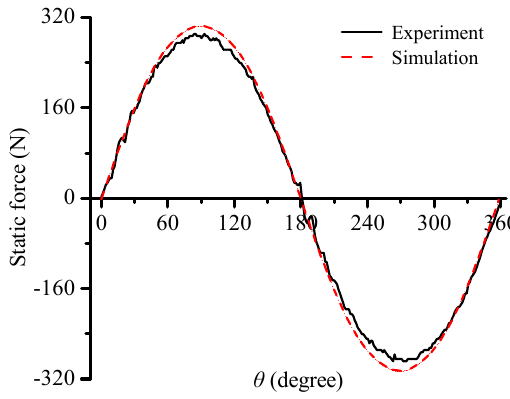
Figure 14. Comparison of the static thrust waveform between simulation result and experiment result.